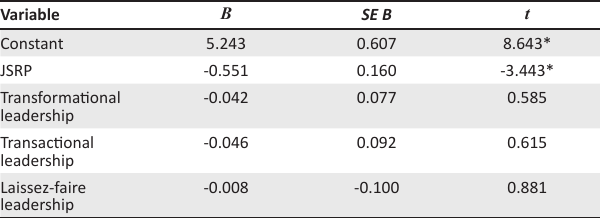
TABLE 7: Summary of multiple regression analysis.